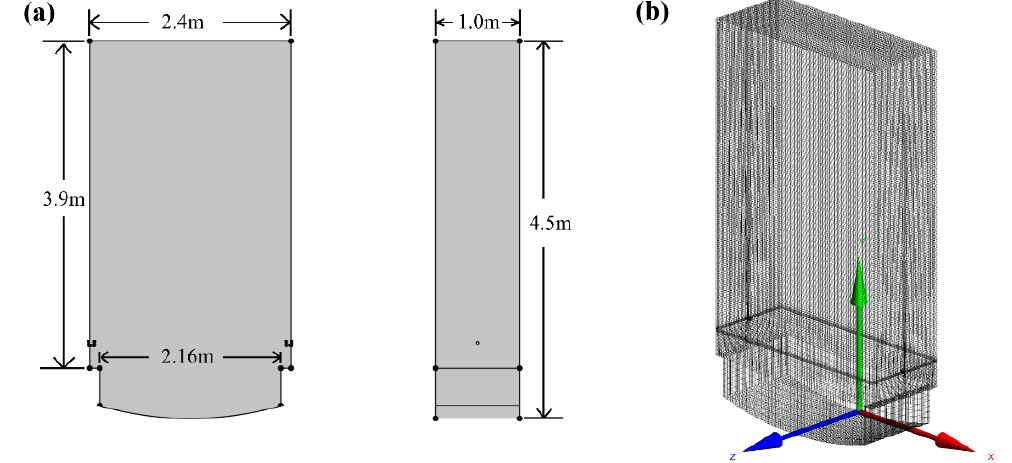
Figure 1. Schematic of computational domain ( a ) and mesh ( b ) used in simulation.